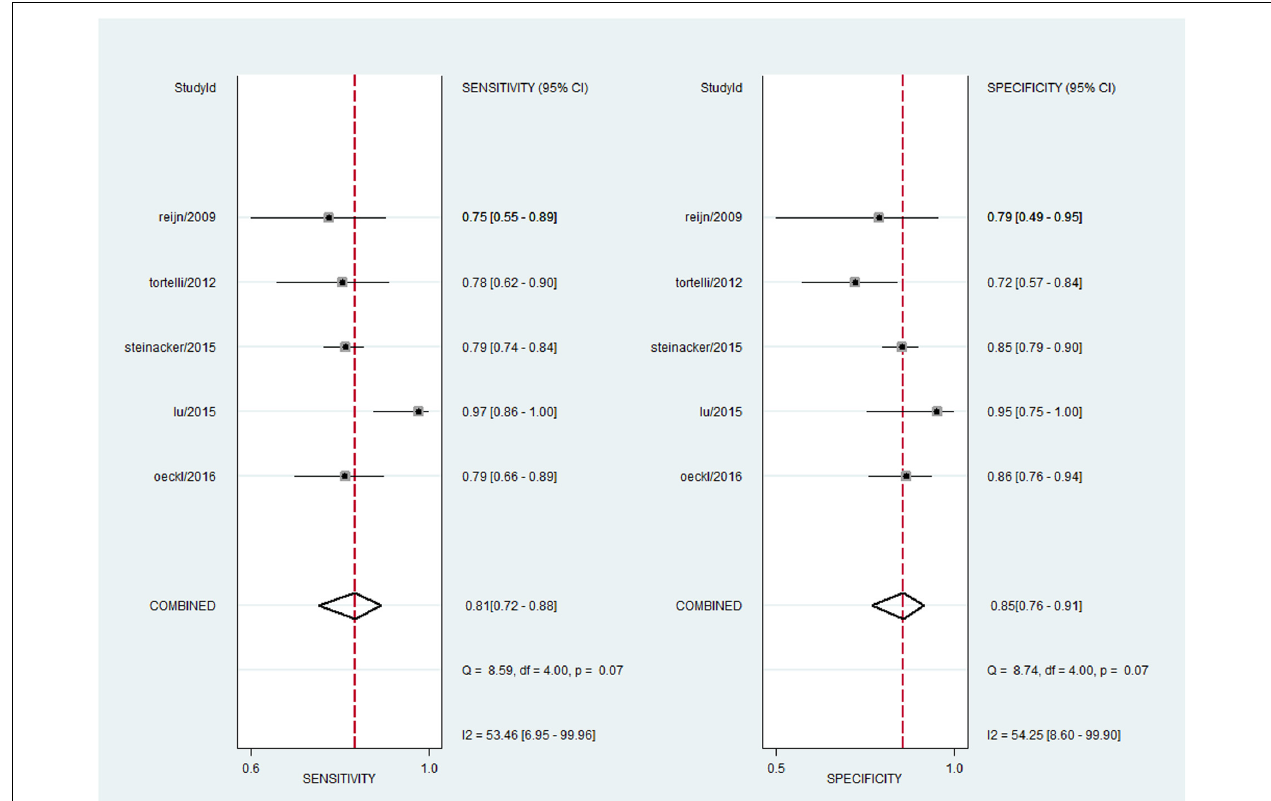
FIGURE 3 | Forest plots showing the sensitivity and specificity of NFL in the diagnosis of